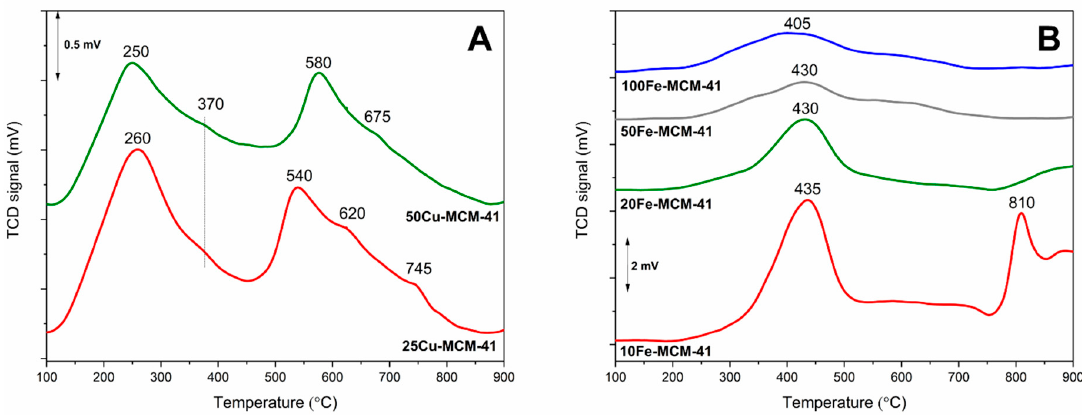
Figure 7. Results of H 2 -TPR studies of the spherical MCM-41 based samples doped with Cu ( A ) and Fe ( B